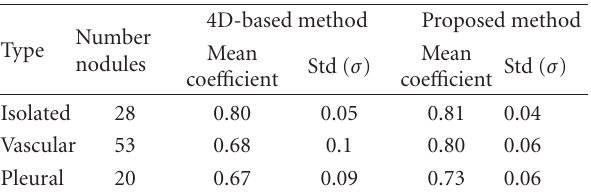
Table 2: Summary of Dice coe ffi cients for di ff erent types of solid nodules based on two di ff erent